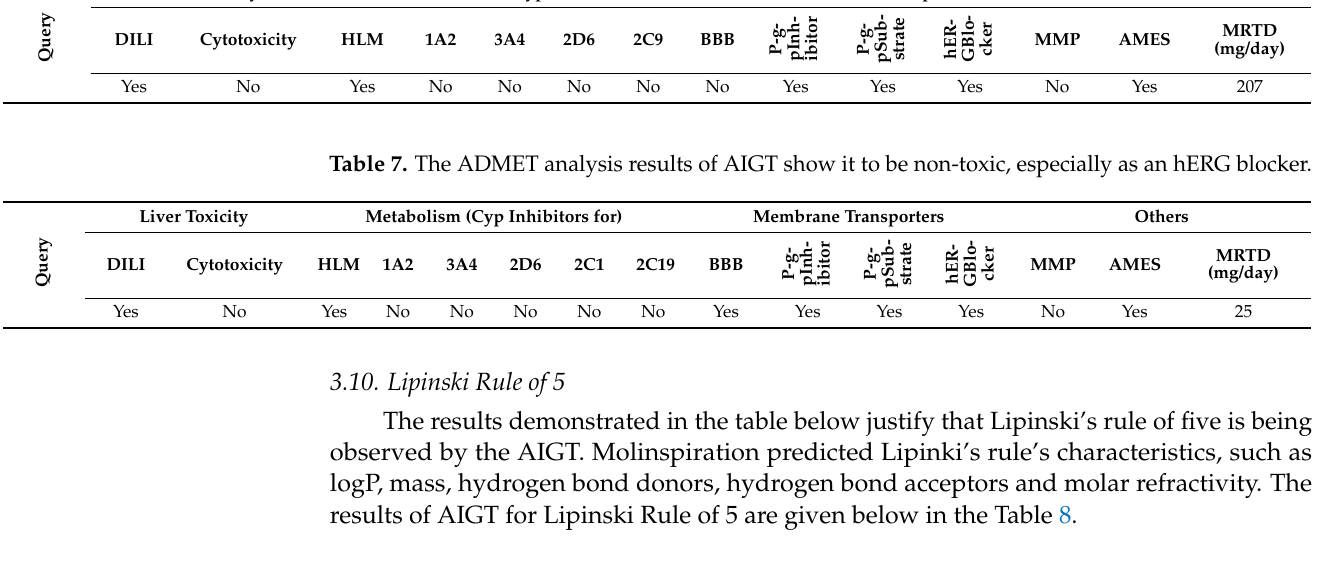
Table 8. The results of AIGT for Lipinski Rule of 5.